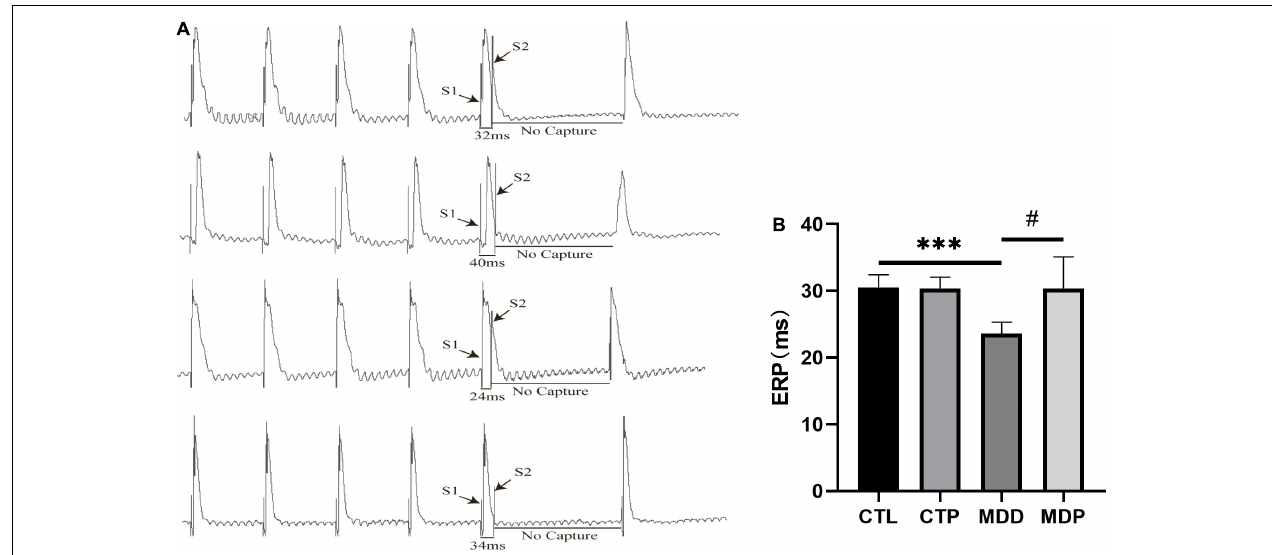
FIGURE 4 | An effective refractory period. (A) Typical atrial ERPs. (B) Average ERP in the four groups. n = 8 per group. *** p < 0.001 vs. CTL; # p < 0.05 vs. MDD.